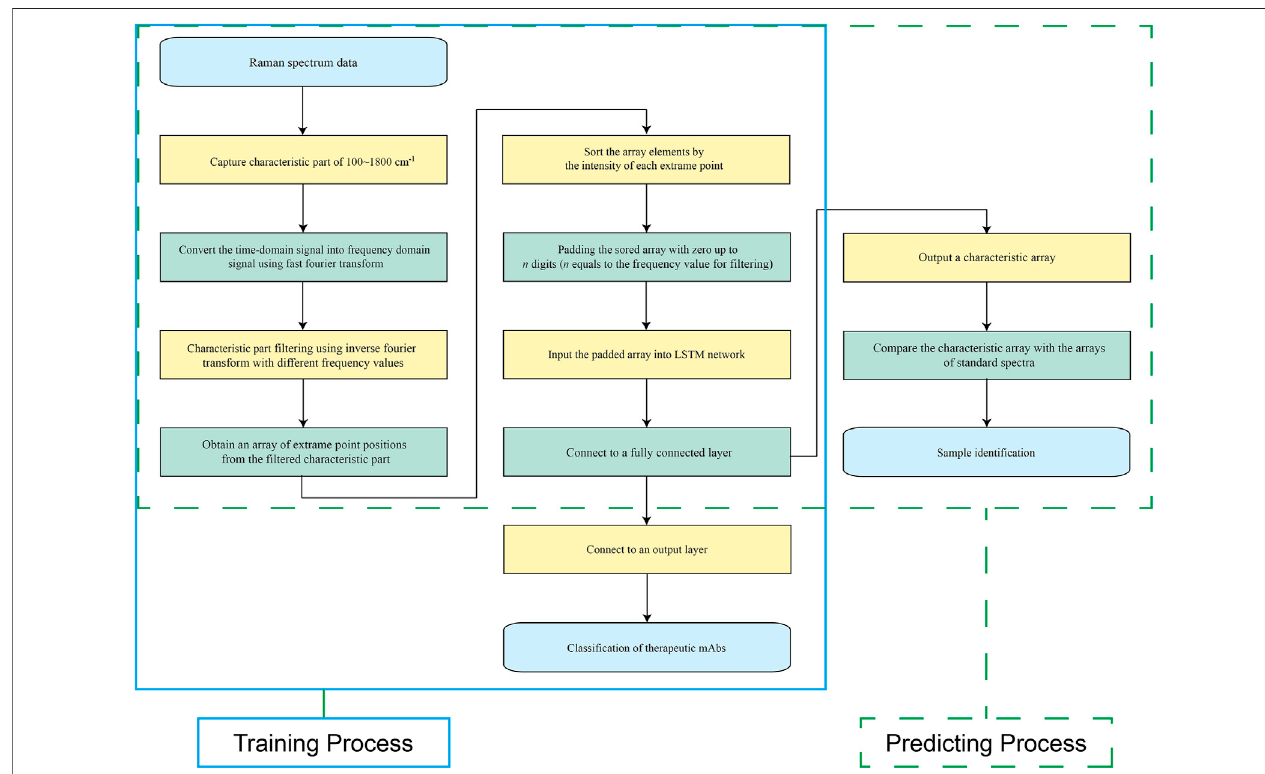
FIGURE2| Schematicviewofthe trainingprocess andprediction process. Thetrainingprocessismarkedwithalightbluefulllinebox,and theprediction process is marked with a green dashed line box.